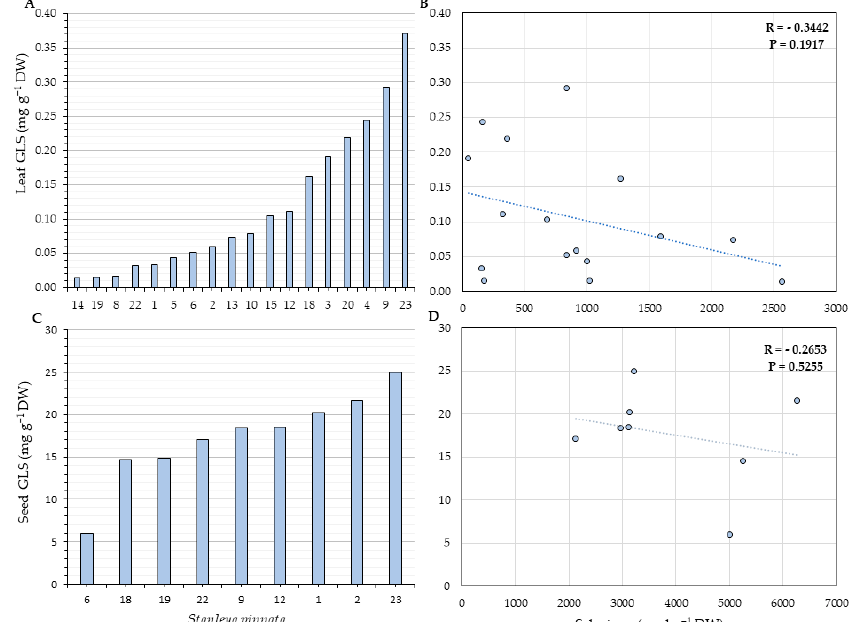
Figure 10. Total glucosinolates (GLSs) concentration in leaves ( A ) and seeds ( C ) and their correlation with leaf ( B ) and seed ( D ) Se concentration for S. pinnata plants growing at Coyote Ridge (locations shown in Figure 2). The numbers on the horizontal axis ( A , C ) represent the collection numbers for individual plants at the locations indicated in Figure 2. The graphs show the correlation coefficient R and p -value for panels ( B , D ).